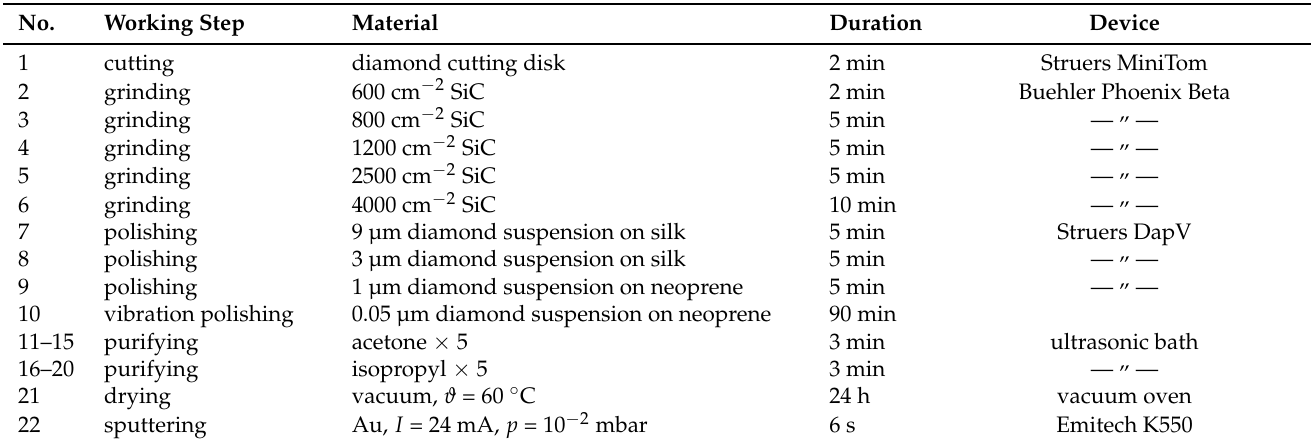
Table 3. Preparation route for EBSD measurements on ceramic PEO